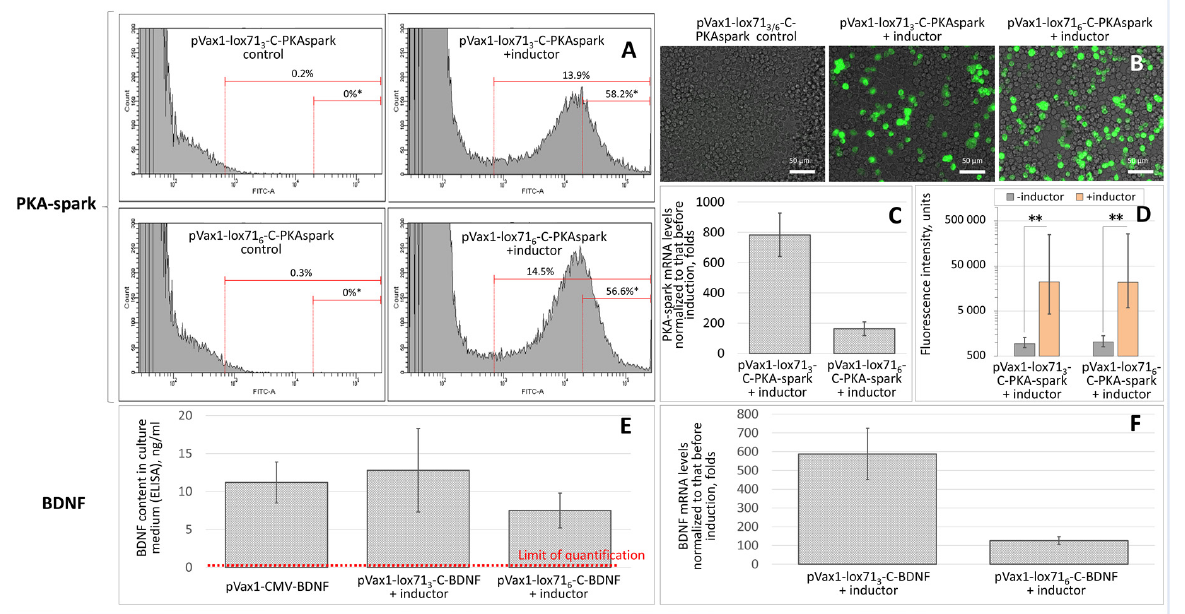
Figure 5. Efficiency of transgene expression in the CreVP64/lox71 system. ( A ) Flow cytometry of cells transfected with constructs encoding PKA-spark. *, The percentage of bright HEK293T cells among all GFP-positive cells. ( B ) Fluorescence microscopy of cells transfected with constructs encoding PKA-spark. ( C , F ) Fold enhancement (to “before induction” level) of PKA-spark ( C ) and BDNF ( F ) mRNAs in HEK293T cells 48 h after induction. ( D ) PKA-spark sensor fluorescence intensity of cells transfected with pVax1-lox71 3/6 -C-PKA-spark with or without induction. **, p < 0.05, n ≥ 30,000. Data are presented as the median (25%; 75%). ( E ) The secretion of human BDNF by transfected cells measured by ELISA 48 h after